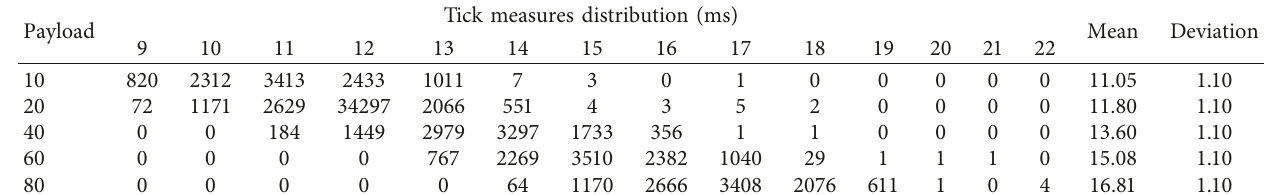
Table 2: Distribution of 10000 tick results in function of